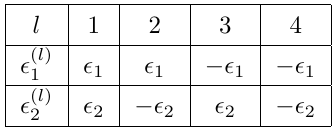
Table 2 . Values of the equivariant parameters for S 2